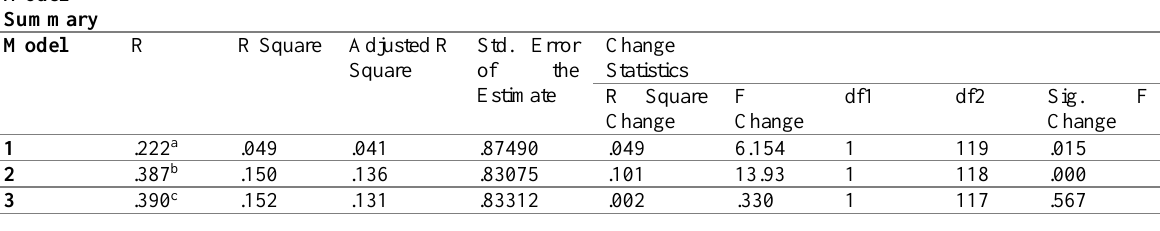
Table 3: Model Summary